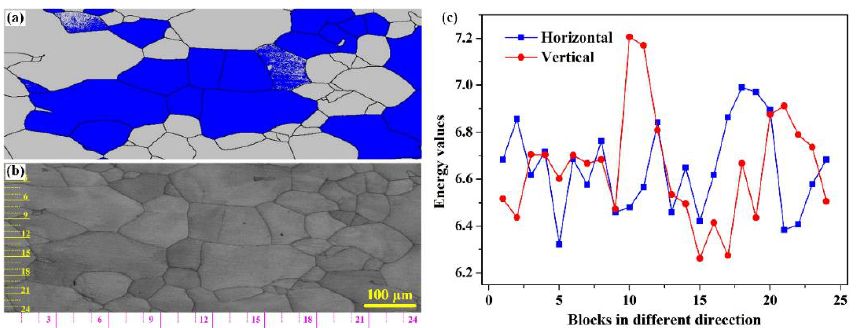
Figure 8. Values of stored energy for different blocks in the testing area. The extracted grains ( a ) and the BC map ( b ), and the evaluated stored energy values ( c ). the BC map ( b ), and the evaluated stored energy values ( c